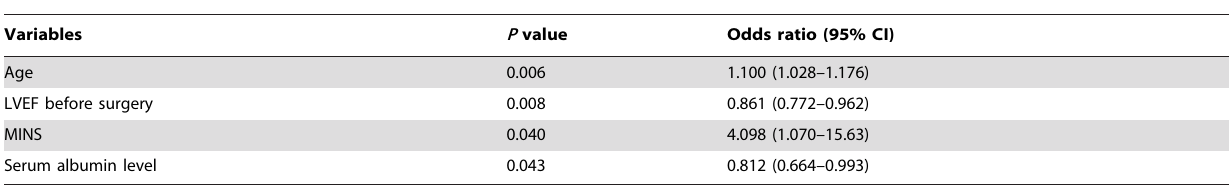
Table 5. Multiple